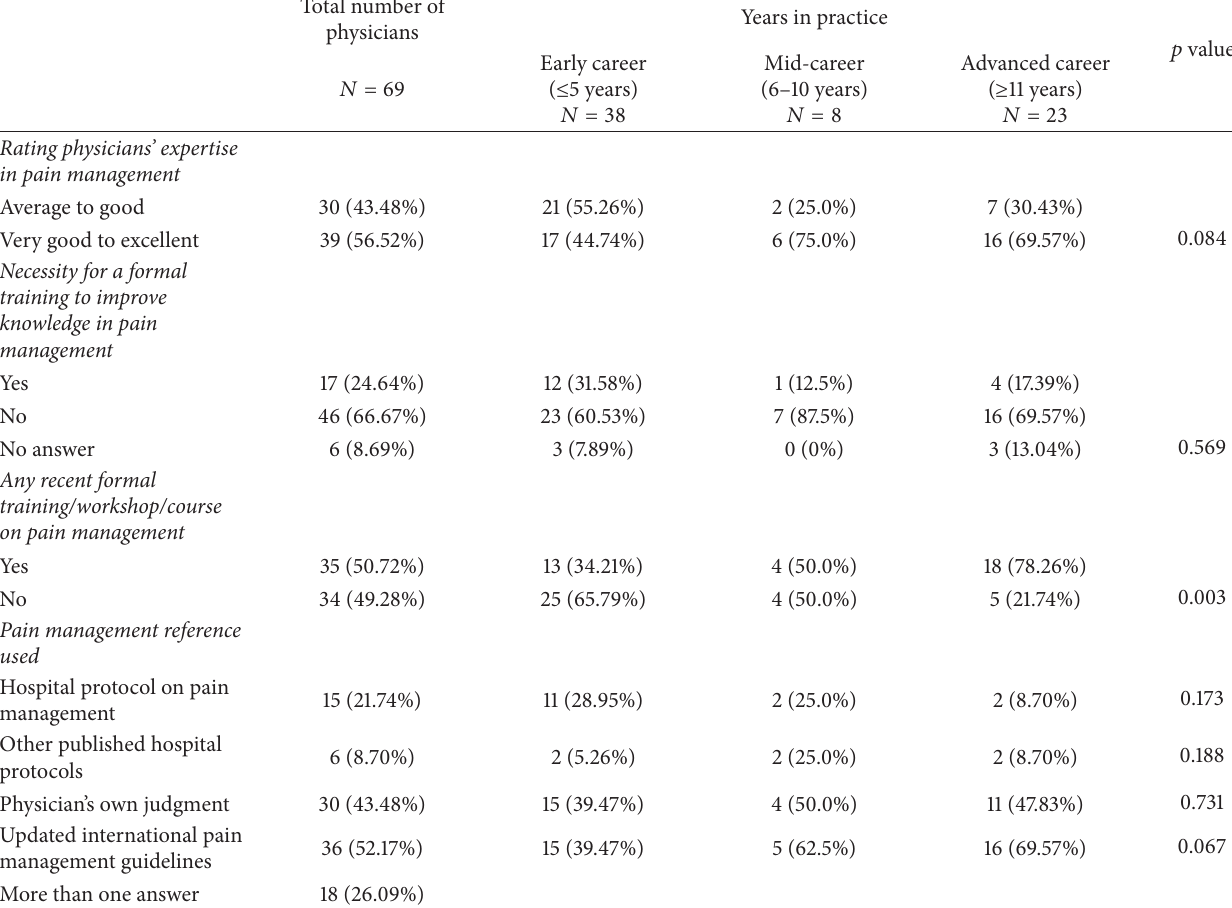
Table 2: Physicians’ assessment of their own competency in pain management based on years in